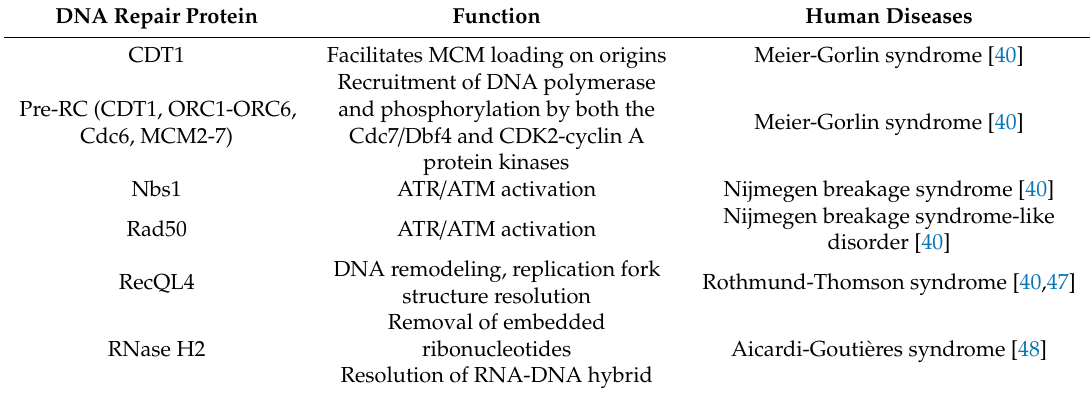
Proteins involved in DNA replication, repair, and replication stress response and associated